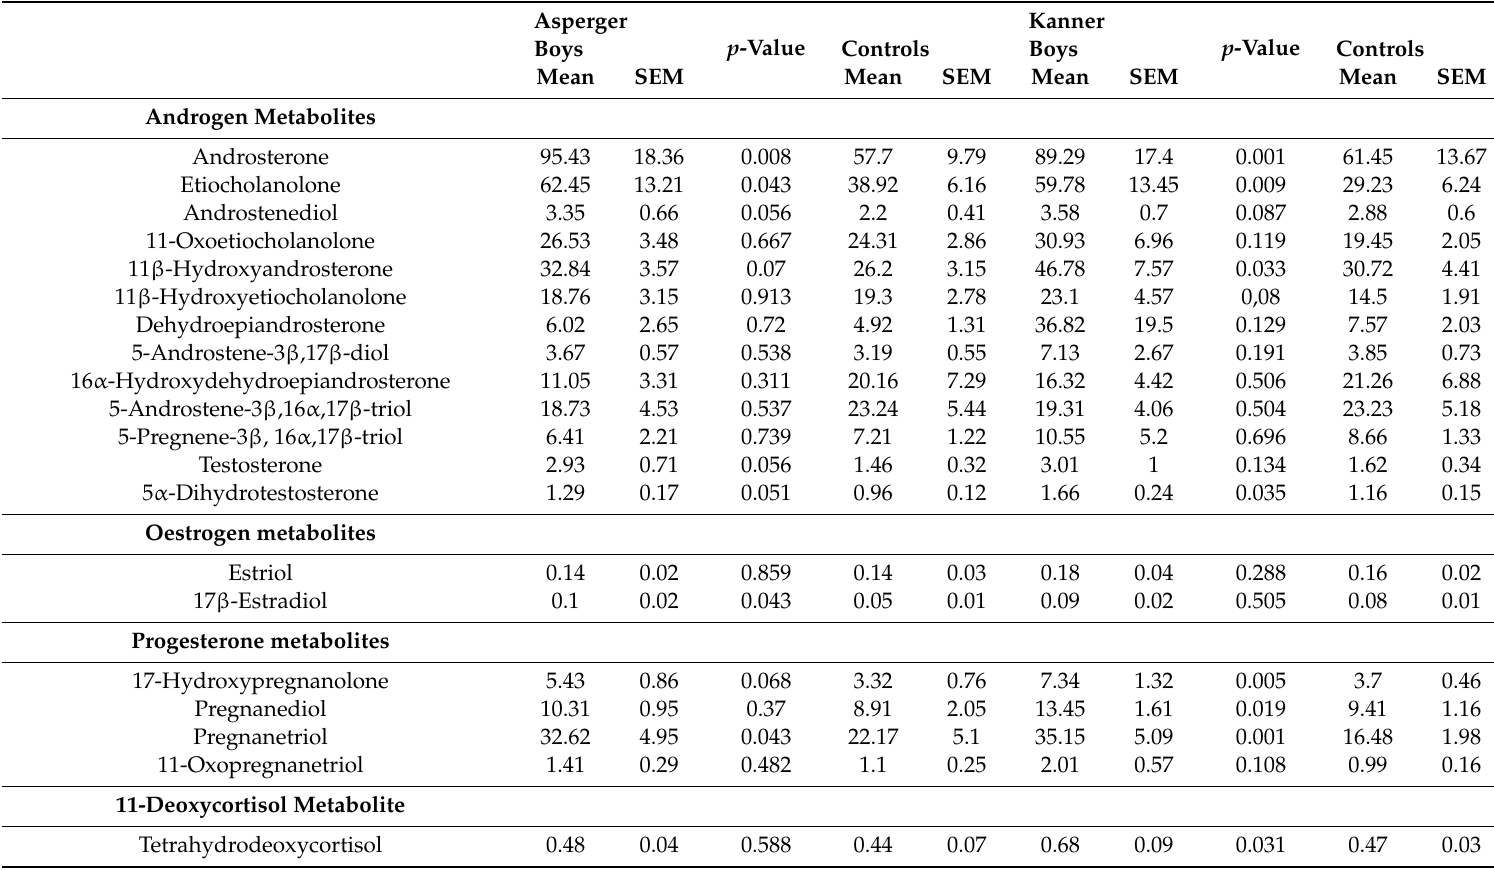
Table 1. Androgen metabolites for boys with Asperger syndrome ( n = 20) versus individually pairwise matched controls ( n = 20) and boys with Kanner syndrome ( n = 21) versus individually pairwise matched controls ( n =